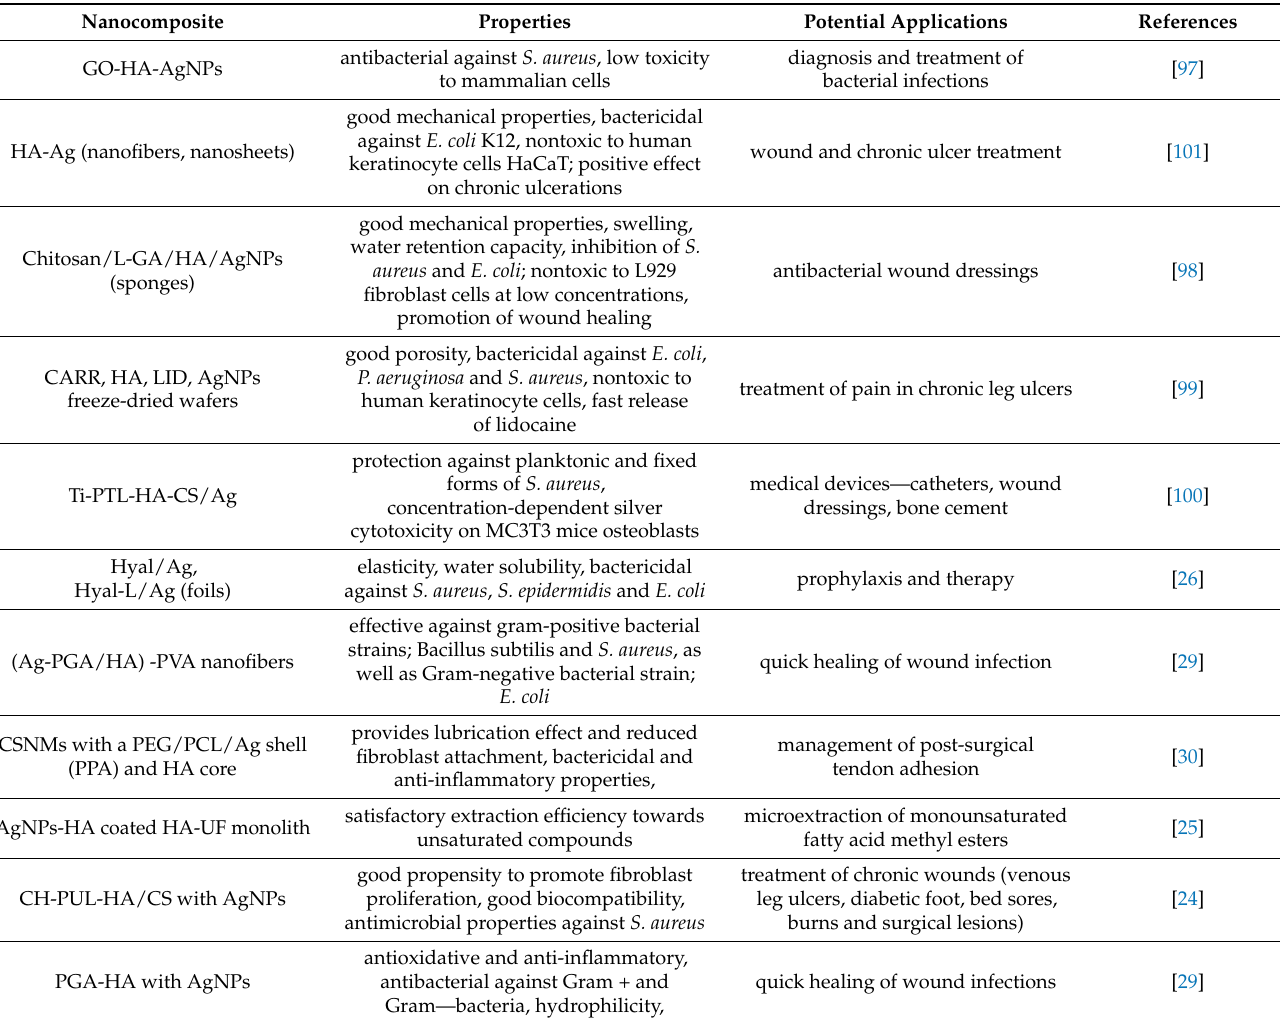
Table 1. Properties and potential applications of Ag NPs and HA containing